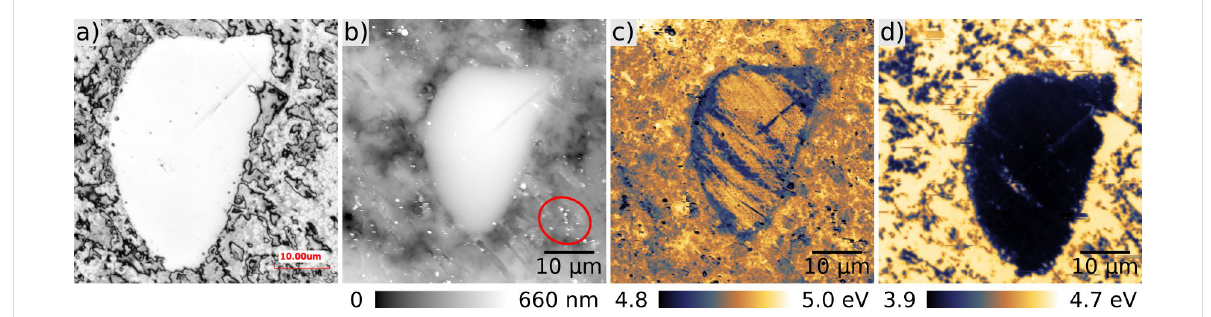
Figure 5: A chromium grain embedded in a polycrystalline copper alloy. a) Measured with a confocal laser microscope. b) Topography and c) KPFM image of the grain before sputtering. d) KPFM image after two sputter cycles for 10 min each with Ar + -ions and a voltage of 1 kV. Small tip changes, as highlighted by the red circle in panel b, are not influencing the work function measurement sustainably. The work function difference between copper and chromium measures ΔΦ = 720 meV. Scan size: 50 × 50 μ m 2 .